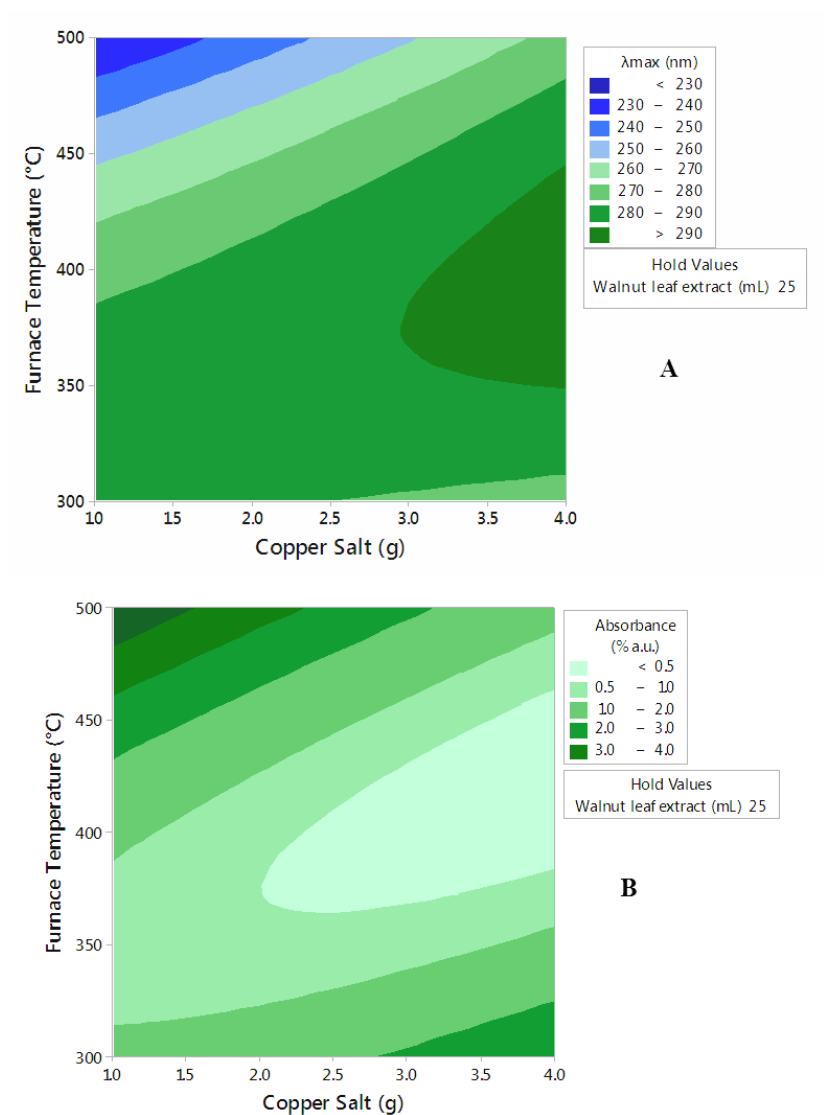
Figure 1: Contour plots for λmax (a) and absorbance (b) of the formed CuO NPs as function of copper salt amount (g), amount of walnut leaf extract (mL) and furnace temperature